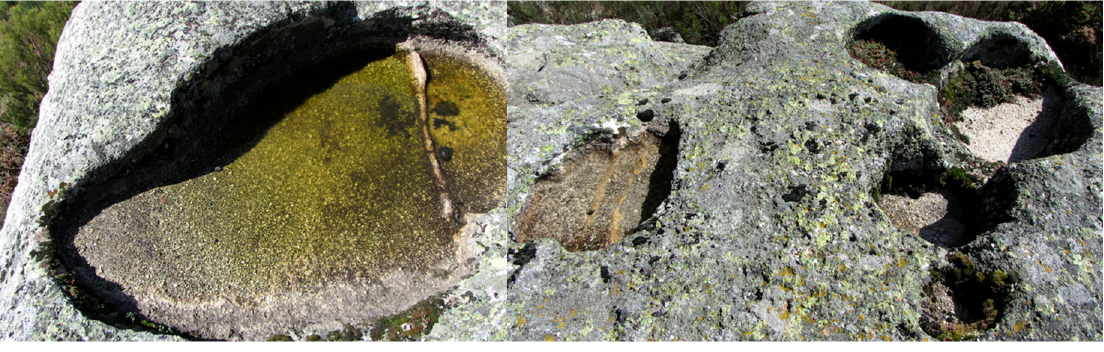
Figure 5. Elliptical shape sink. Note the protrusion of a small quartz strand more resistant to the advancement of the weathering ( left ). Set of sinks in different evolution states ( right ).